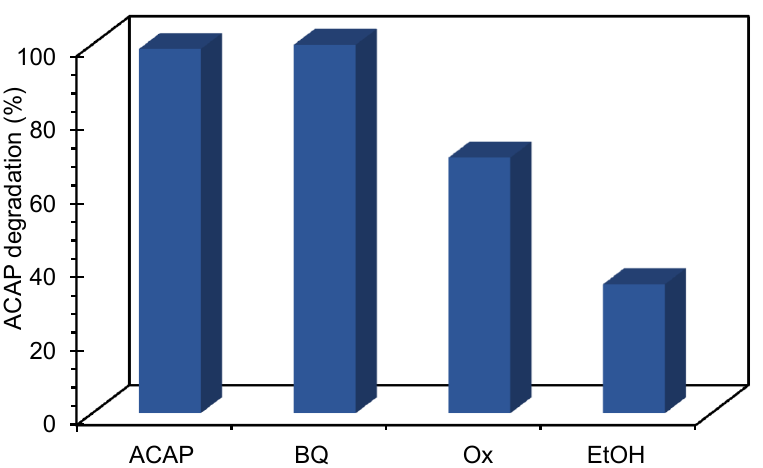
Figure 7. Photodegradation rate of ACAP, during 60 min of irradiation when in the presence of selected scavengers and using CoFeTNW as catalyst.